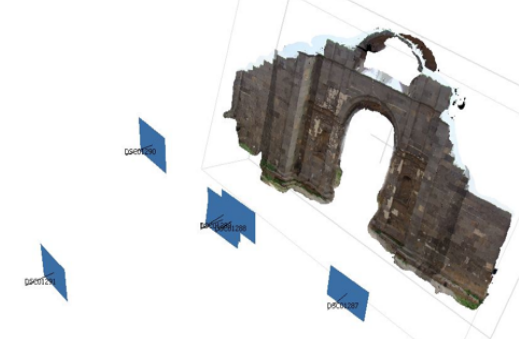
Figure 10. Images available for the Western Gate